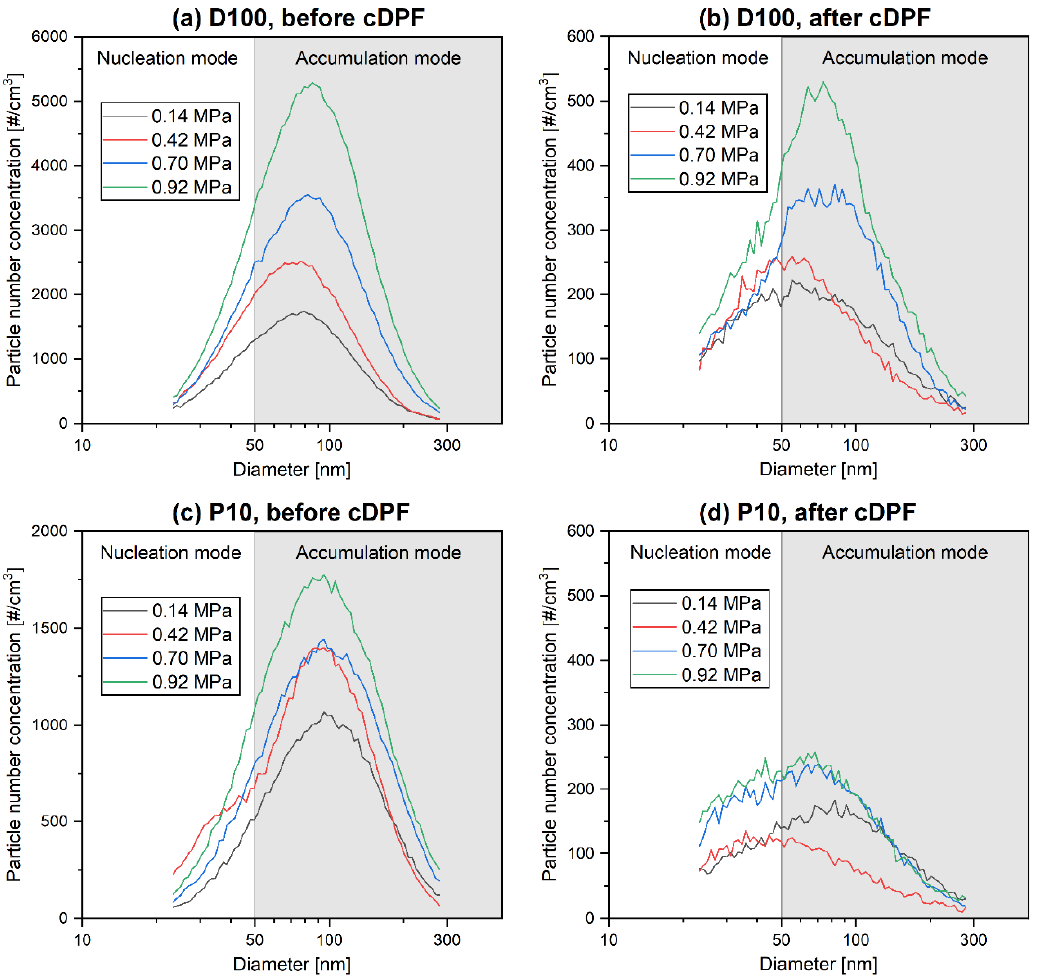
Figure 1. Particulate number and size distributions under various engine loads: ( a ) D100 fuel, before cDPF; ( b ) D100 fuel, after cDPF; ( c ) P10 fuel, before cDPF; and ( d ) P10 fuel, after cDPF.